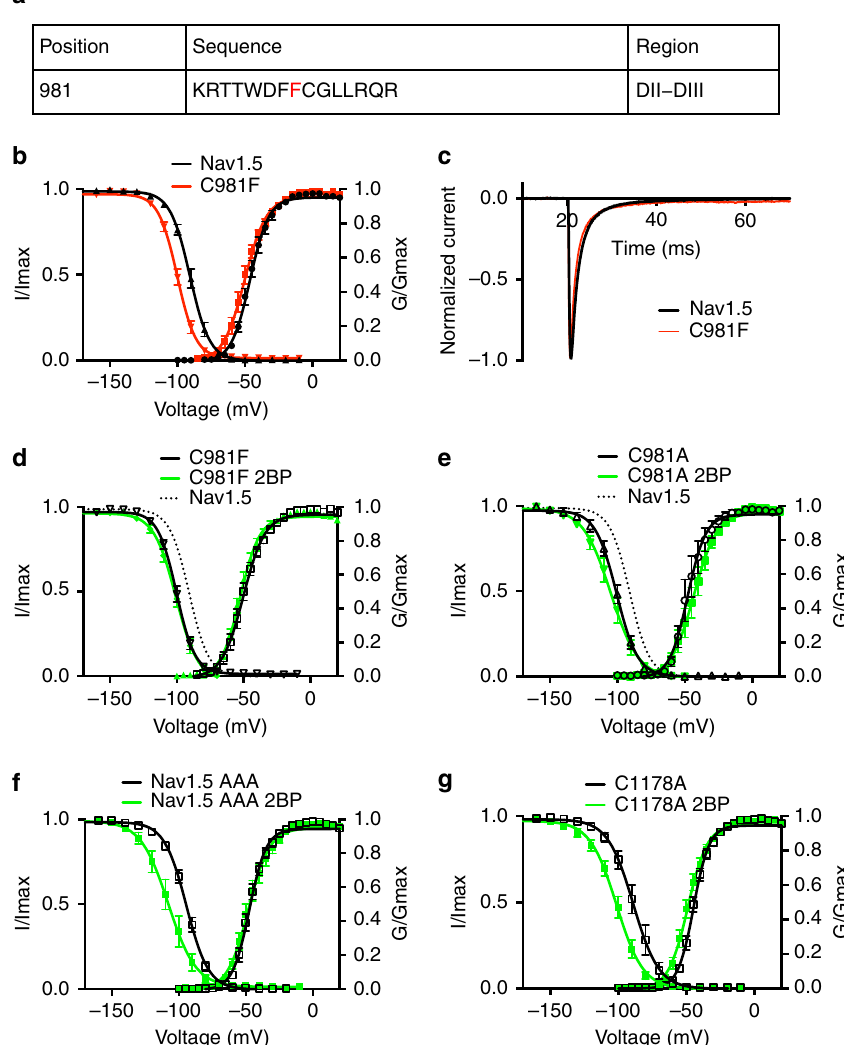
Figure 8 | Loss of cysteine mutation from patient with cardiac arrhythmia affects biophysical properties of Nav1.5. All data are shown as mean ± s.e.m. ( a ) Long-QT3 mutation (C981F, red) that can potentially abolish the endogenous palmitoylation in wild-type Nav1.5. ( b ) Comparison of voltage dependence of activation and steady-state inactivation of wild-type Nav1.5 (black) and C981F mutant channels (red). n ¼ 10. ( c ) Normalized current of wild-type Nav1.5 channel (black) and Nav1.5-C981F (red). Current traces were averaged data from 9 measurements. ( d ) Nav1.5-C981F channel activation and steady-state inactivation with (green) and without (black) 2-Br-palmitate(2BP) treatment. n ¼ 10. ( e ) Nav1.5-C981A voltage dependence of activation and steady-state inactivation with (green) and without (black) 2-Br-palmitate treatment. The dotted line indicates the wild-type Nav1.5 steady-state inactivation. n ¼ 7. ( f , g ) 2-Br-palmitate treatment (green) affect Nav1.5-AAA ( f ) and Nav1.5-C1178A ( g ) voltage dependence of activation and steady-state inactivation. n ¼